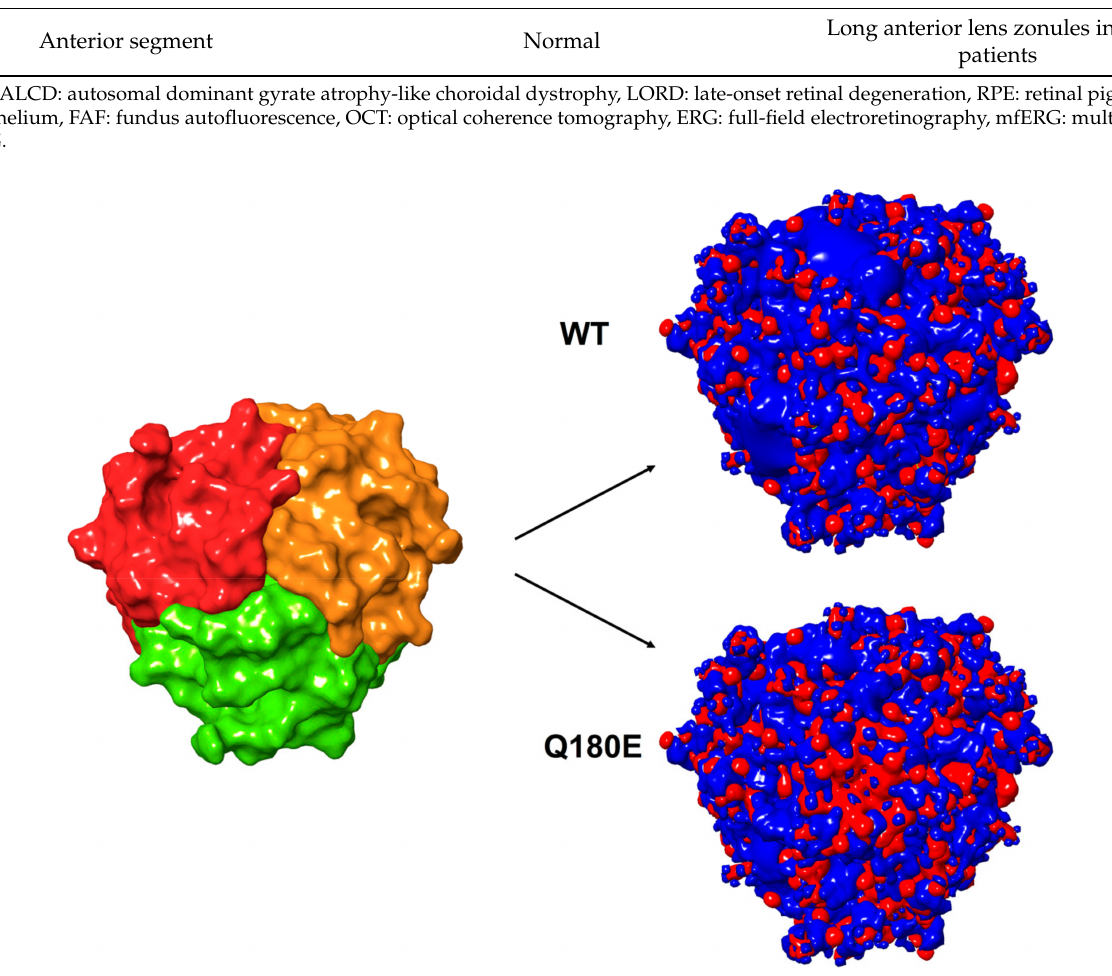
Figure 10. Electrostatic isopotential surfaces of WT and Q180E homozygous C1QTNF5 trimers forming a single globular head show unfavorable electrostatic contributions to association in the case of mutated protomers. The top view of the molecular surface of protomers A, B and C (colored in red, orange and green, respectively) is shown to clarify the relative orientation of each protomer. The electrostatic isopotential surfaces corresponding to − 10 kT/e and 10 kT/e are shown in red and blue,